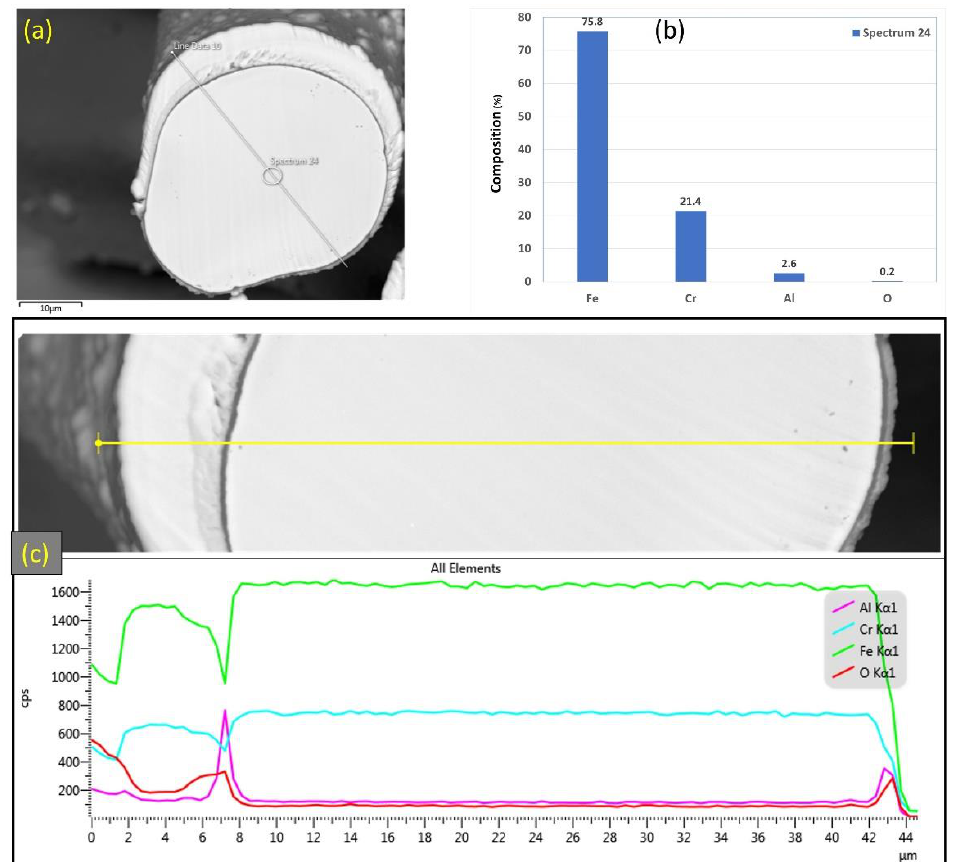
Figure 10. ( a ) SEM micrograph of a cross section of the 17 μm FeCrAl fiber after one MSHT cycle, ( b ) EDS scan at the center of the fiber, ( c ) the characteristic X-ray counts along the specified line scan (Line Data 10) marked in ( a ).